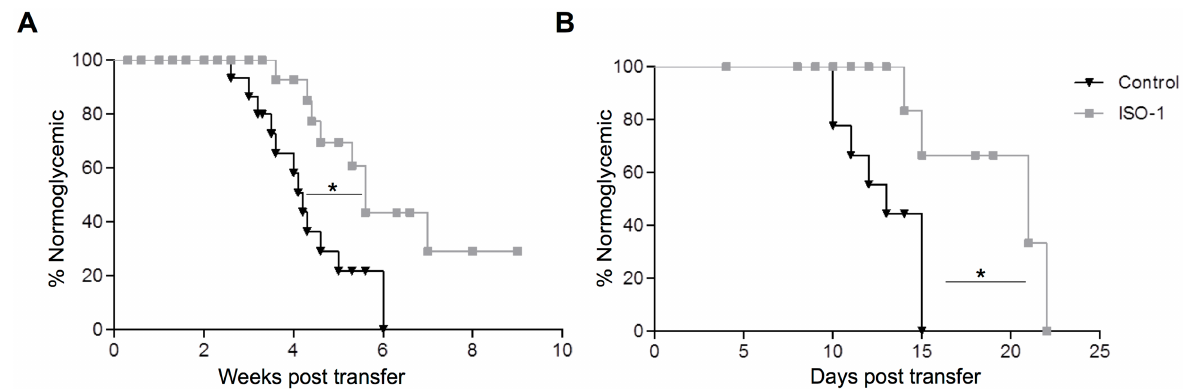
Fig 5. Effect of the MIF inhibitor, ISO-1, on the development of diabetes in vivo . (A) Percentageof normoglycemic mice following the adoptivetransfer (i.v.) of splenocytes(1 × 10 7 ) isolated from newly-diagnosed diabeticNOD mice into NOD.SCID mice (6–8 week- old). The recipientanimals additionally receivedISO-1 (100 μ g; i.p.) (grey squares) (n = 9) or vehiclecontrol (black triangles)(n = 12) five times a week and were monitoredtwice weekly for the development of diabetesfor a total of 10 weeks. (B) Percentage of normoglycemic mice followingthe transfer of activated CD4 + T cells from BDC2.5 Tg (1 × 10 5 ) mice into NOD.SCID mice. Similarly, the recipientmice receivedISO-1 (100 μ g; i.p.) (grey squares) (n = 4) or vehiclecontrol (black triangles)(n = 7) five times a week and were monitored daily for the development of diabetes. In all panels,statistical significance between groupswas determinedby Mantel-Coxlog-ranktest; * p < 0.05.